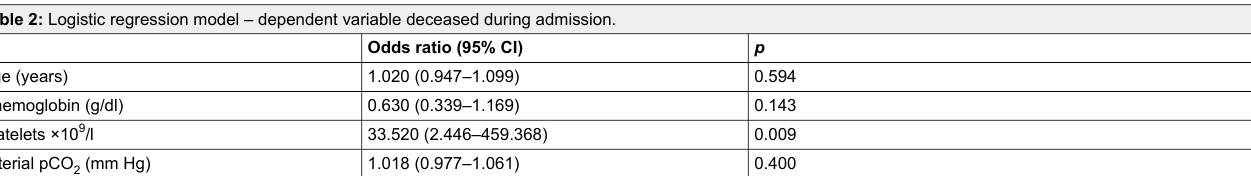
Table 2: Logistic regression model – dependent variable deceased during